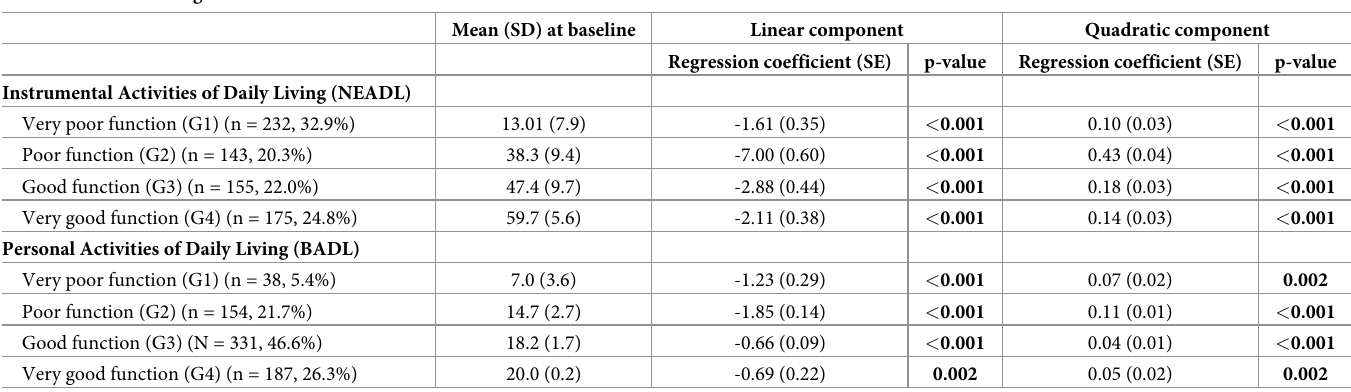
Table 2. Results of the growth mixture